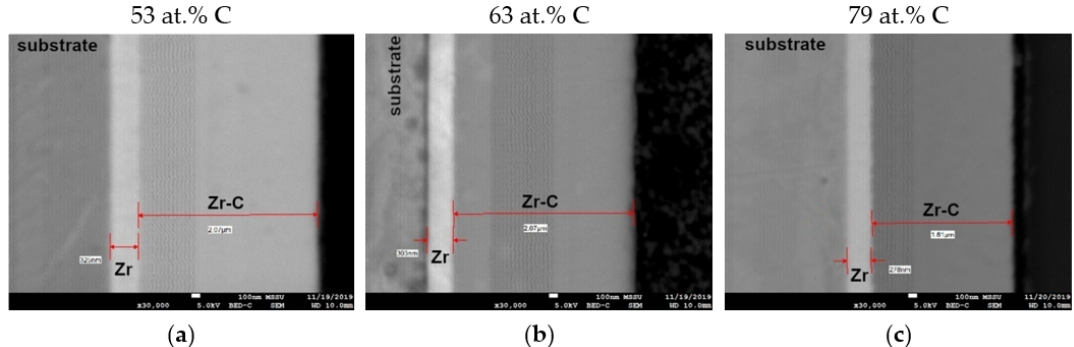
Figure 3. Backscattered electron (BSE) cross-sectional micrograph of samples ( a ) Zr–C with 53 at.% C, ( b ) Zr–C with 63 at.% C, ( c ) Zr–C with 79 at.% C.